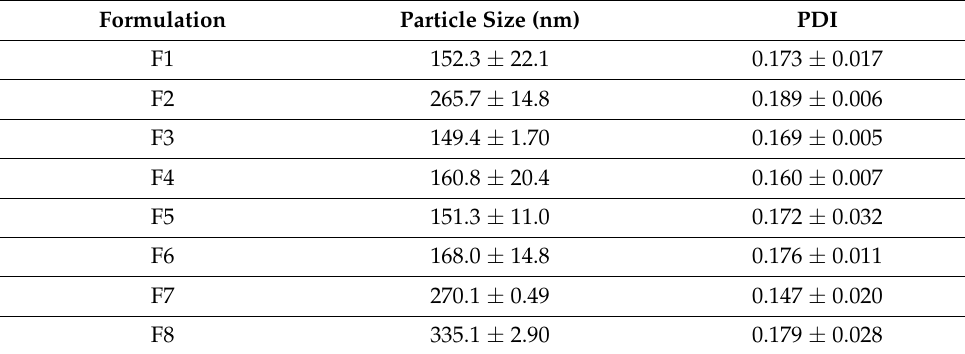
Table 2. The particle size of MFA in various formulations.